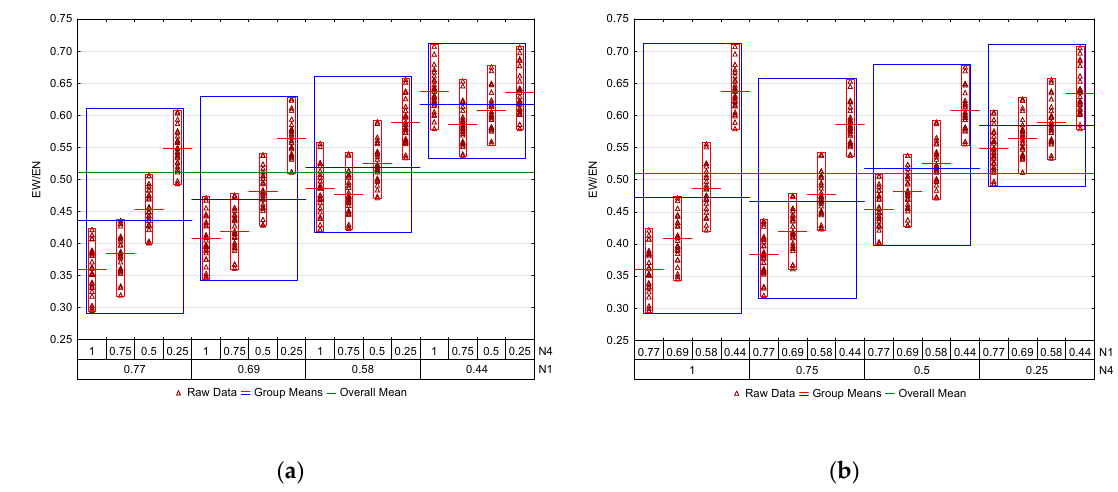
Figure 7. Variability plots of EW / EN illustrating: ( a ) N4 impact for various N1; ( b ) N1 impact for various N4.